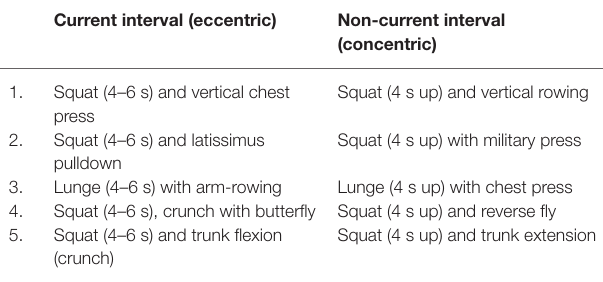
TABLE 1 | Exemplary selection of exercises (1–5) performed during WB-EMS with a detailed description of the individual phases of one single repetition (eccentric and